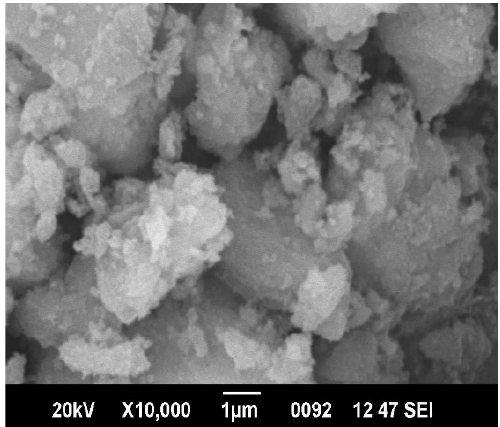
Figure 4. SEM images of Al 2 O 3 nanoparticles.